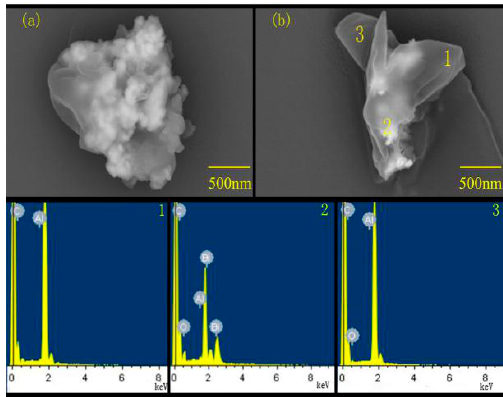
Figure 3. ( a , b ) are backscattered scanning electron micrographs; 1, 2, and 3 are, respectively, the EDS spectra of the corresponding positions in Figure 3b.